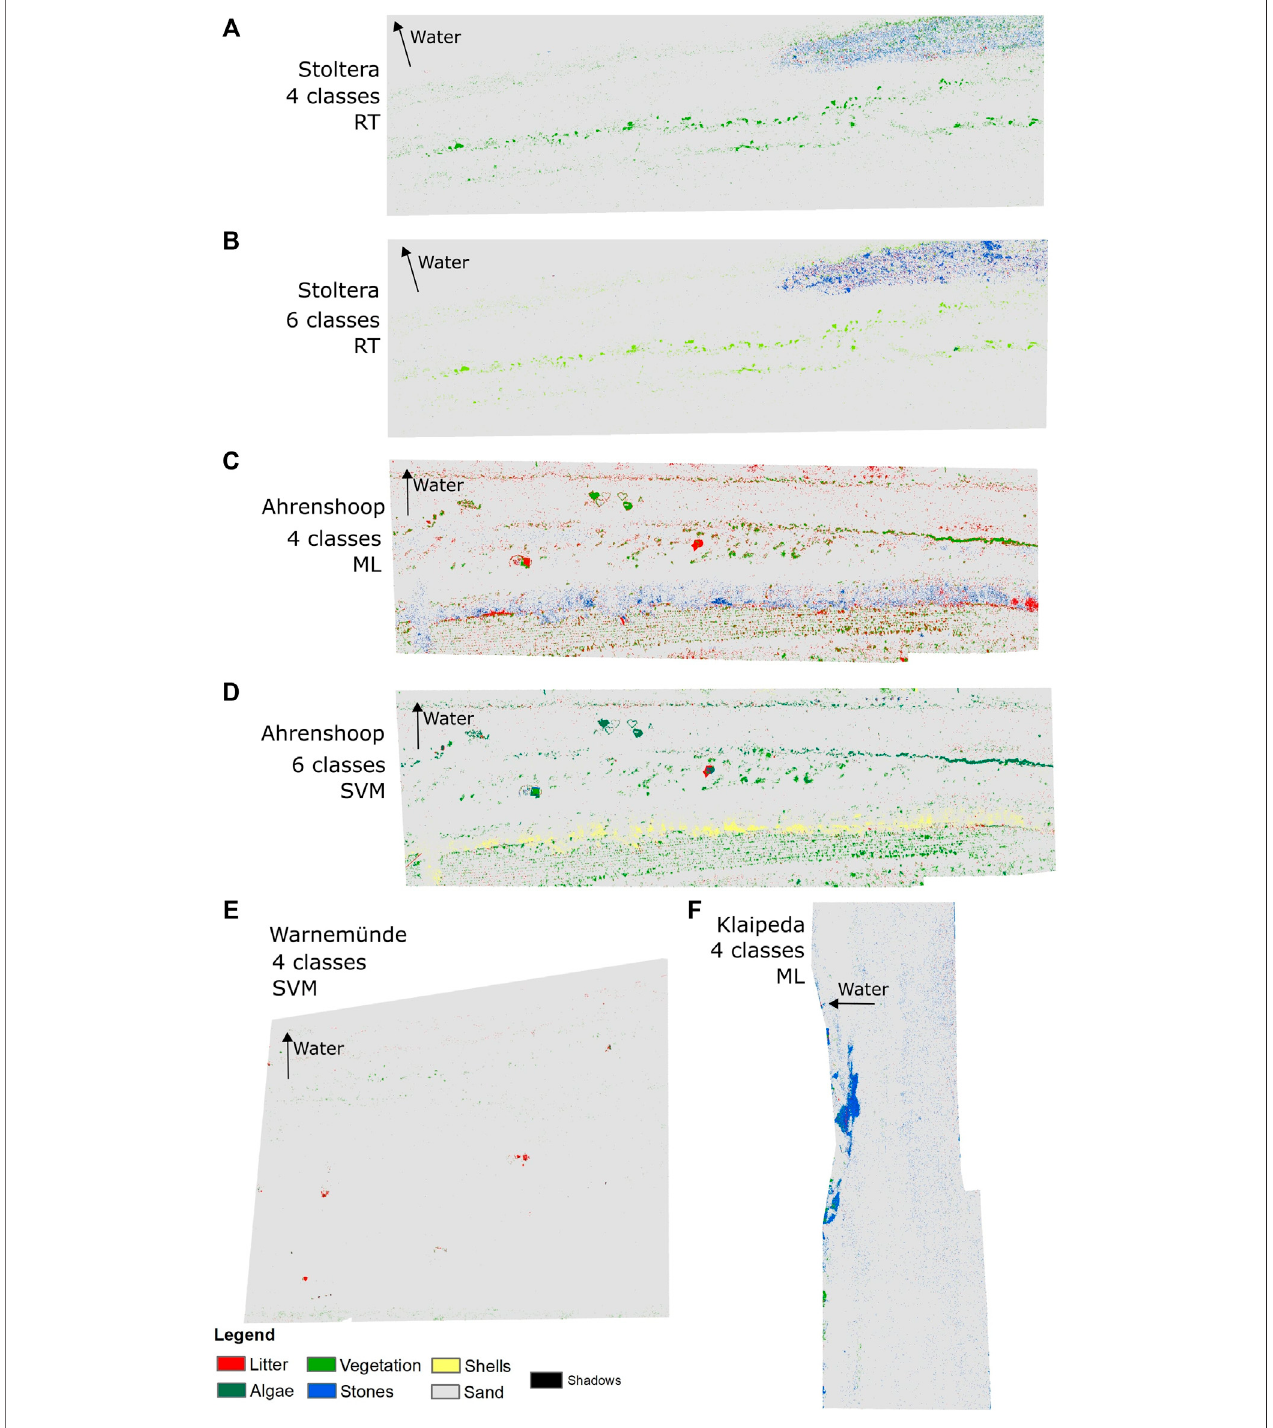
FIGURE 6 | Object-based supervised classi fi cation of 100 m beach transects taken at 10 m fl ight height. Only the results with best total accuracy (TA), producer ’ s accuracyforlitter(PA)andkappavalueofagreementforwith4and6classesareshownforeachsite:Stoltera (A,B) ,Ahrenshoop (C,D) ,Warnemünde (E) andKlaipeda (F) .